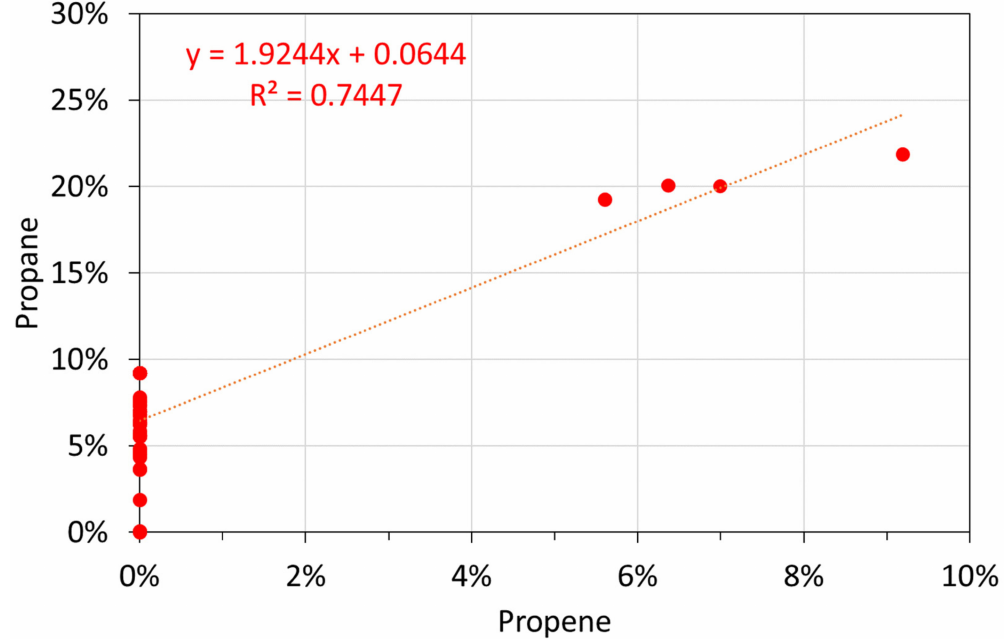
Figure A12. Molar alkane oil analyses: propene vs.